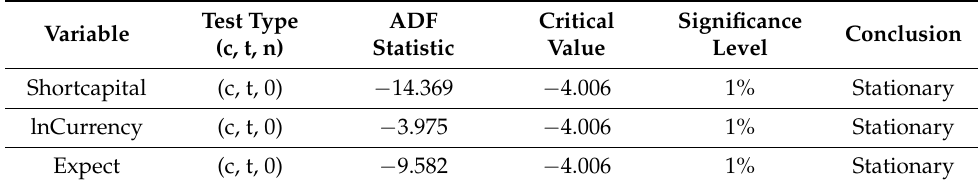
Table 2. ADF test results for variables.